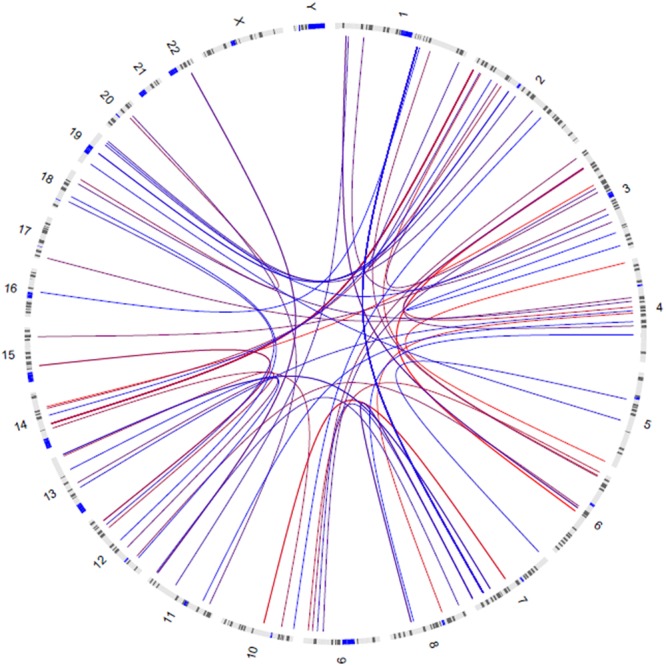
Circos visualization of mapped SNP-SNP interactions for BMI (P < 1 × 10-9). The curves represent the interactions between the two SNPs, and the color gradually changes from red to blue as the P-value decreases.